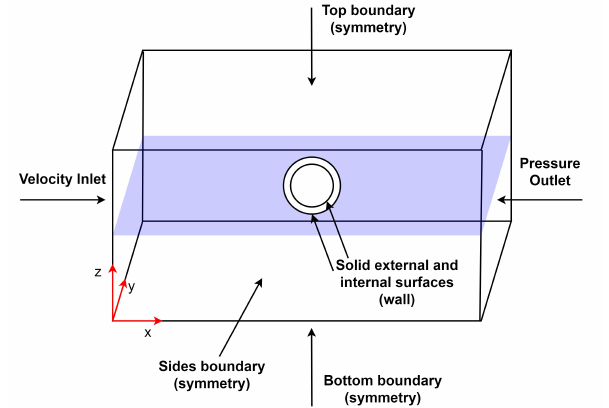
Figure 2. Boundary conditions applied in the